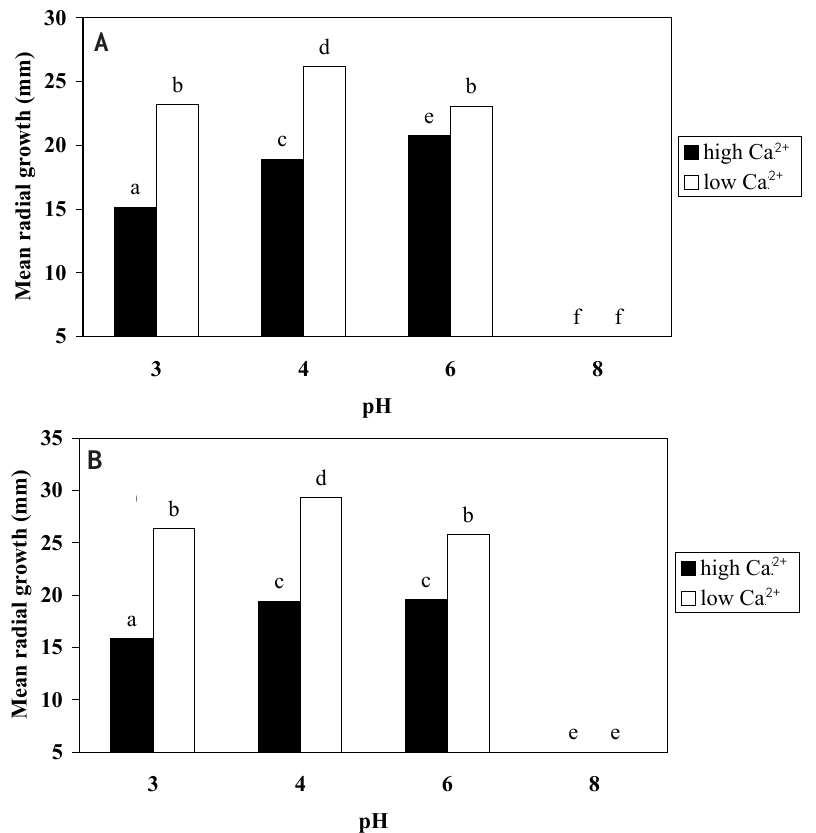
Fig. 3. Effect of pH and of calcium ion concentration on radial growth of Phaemoniella chlamydospora Pch 52 (a) and Pch16 (b) on EPA containig pectin as the sole carbon source. Mean results of 6 plates. SE< ± 0.7 mm. Radial growth was measured 15 days after incubation at 24°C. The differences among means were evaluated with Tukey’s HSD test ( P <0.01). Bars with different letters are significantly different ( P